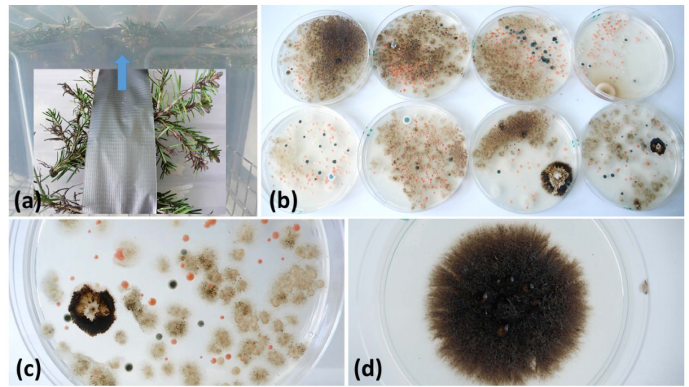
Figure 6. Isolation of Delphinella abietis from ascospores. ( a ) Shoots from subalpine fir ( Abies lasiocarpa ) with dead needles due to attack by D. abietis were attached to the underside of the lid (indicated by blue arrow) of a moist chamber to disperse ascospores; ( b ) numerous, brown colonies of the fungus appeared on 8 Petri dishes (containing acidified PDA) located below the branches inside the moist chamber for 48 h; ( c ) the largest, black colony is Sydowis polyspora ; ( d ) a pure, 17 day old culture of D. abietis . Photos: Venche